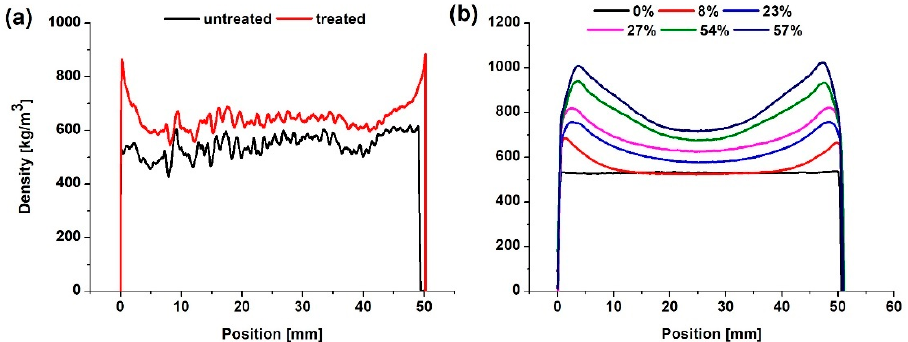
Figure 6. The density profiles ( a ) of a specimen with the WPG of 23% measured in a radial direction; ( b ) the overlay of the density profiles of selected specimens measured in the tangential direction.